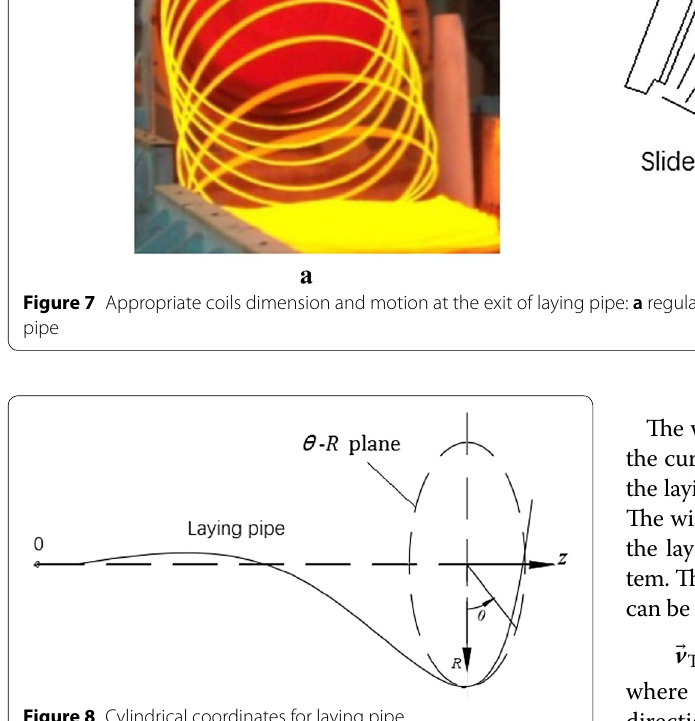
Figure 8 Cylindrical coordinates for laying